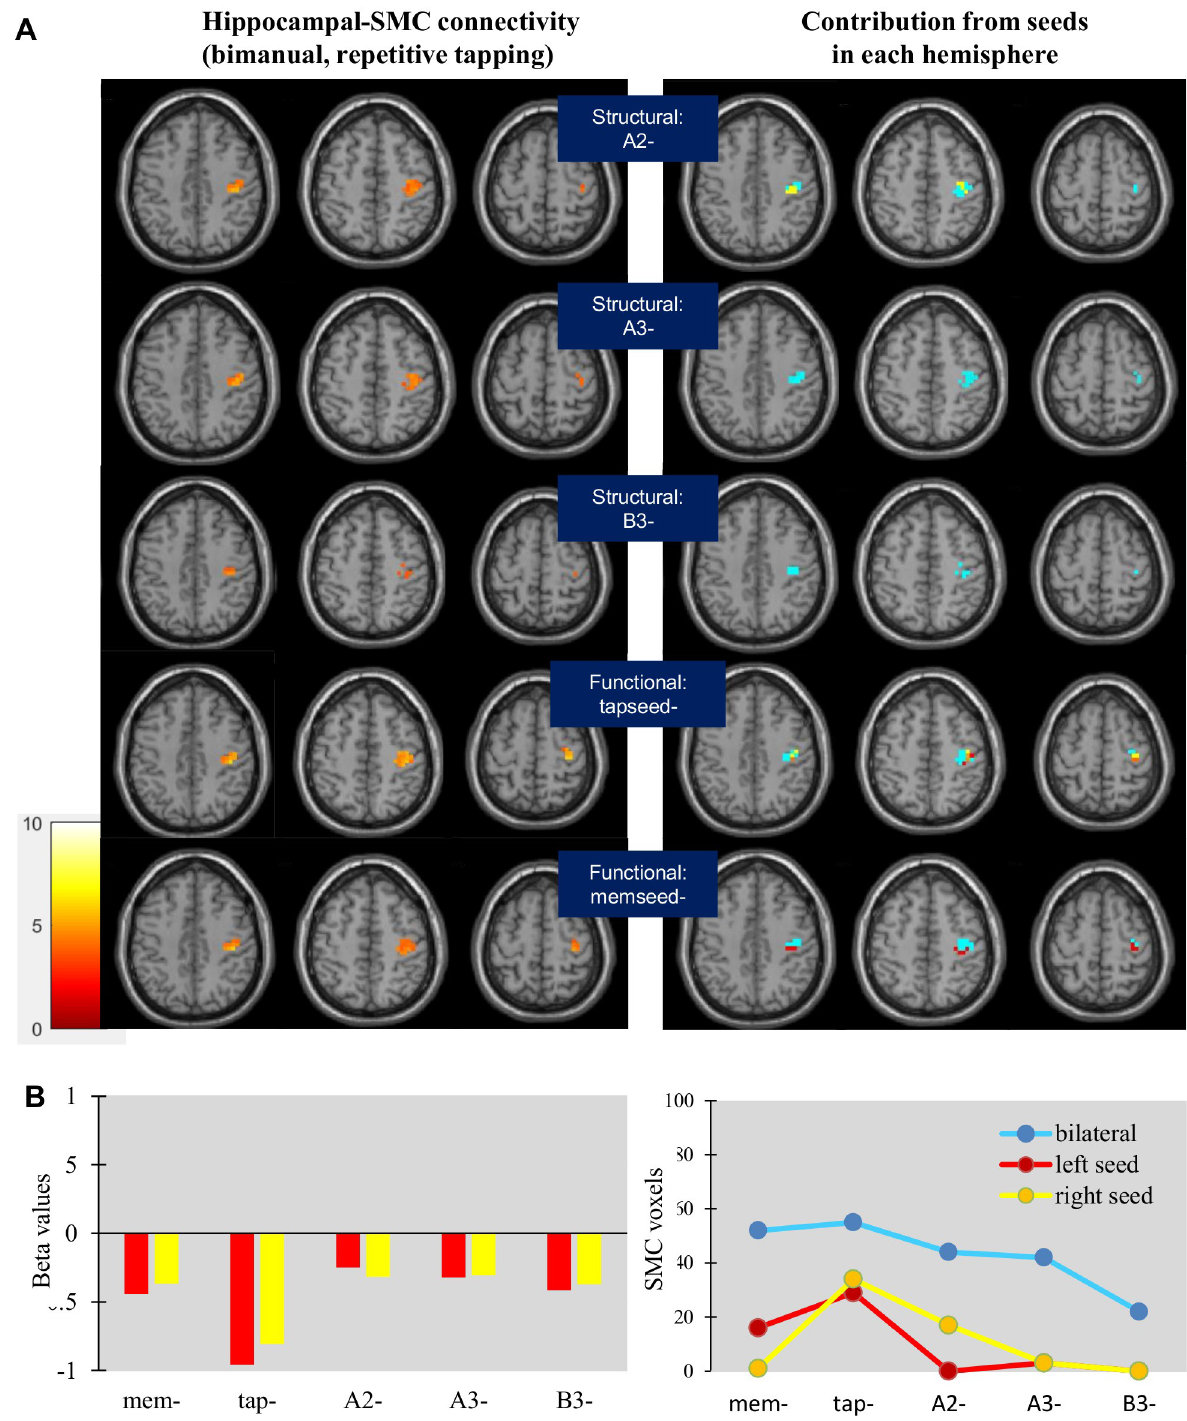
Fig 6. Sensorimotor connectivity of structural and functional seeds during paced repetitive tapping. (A) Negative connectivity generated from structural and functional seeds was observed in the right SMC, almost exclusively from global analysis of the left and right hippocampus. (B) Structural seeds showed greater negative connectivity in the right SMC during repetitive tapping, whereas functional seeds showed greater negative connectivity in the left SMC (light blue) and positive connectivity in the right SMC (magenta) during sequence learning. (C) Beta values indicated equal contributions from the left and right hippocampus (left), with global analysis required to demonstrate most connectivity effects (right).